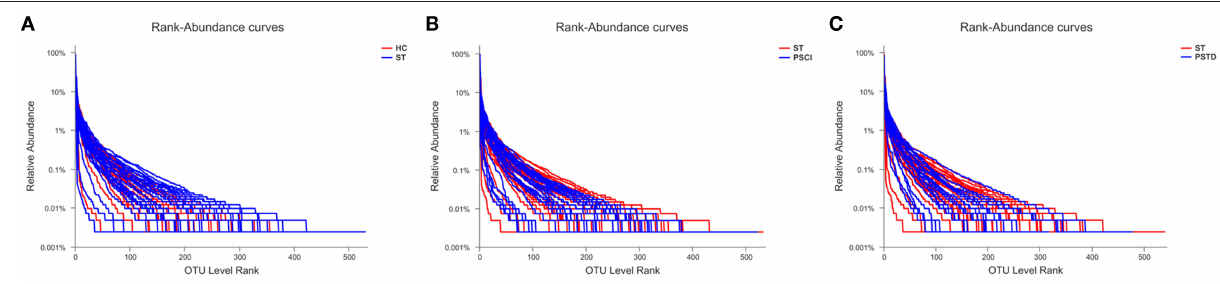
Escherichia-Shigella , Megamonas, and Blautia were the most predominant genera in the ST vs. HC group ( Figure 4A